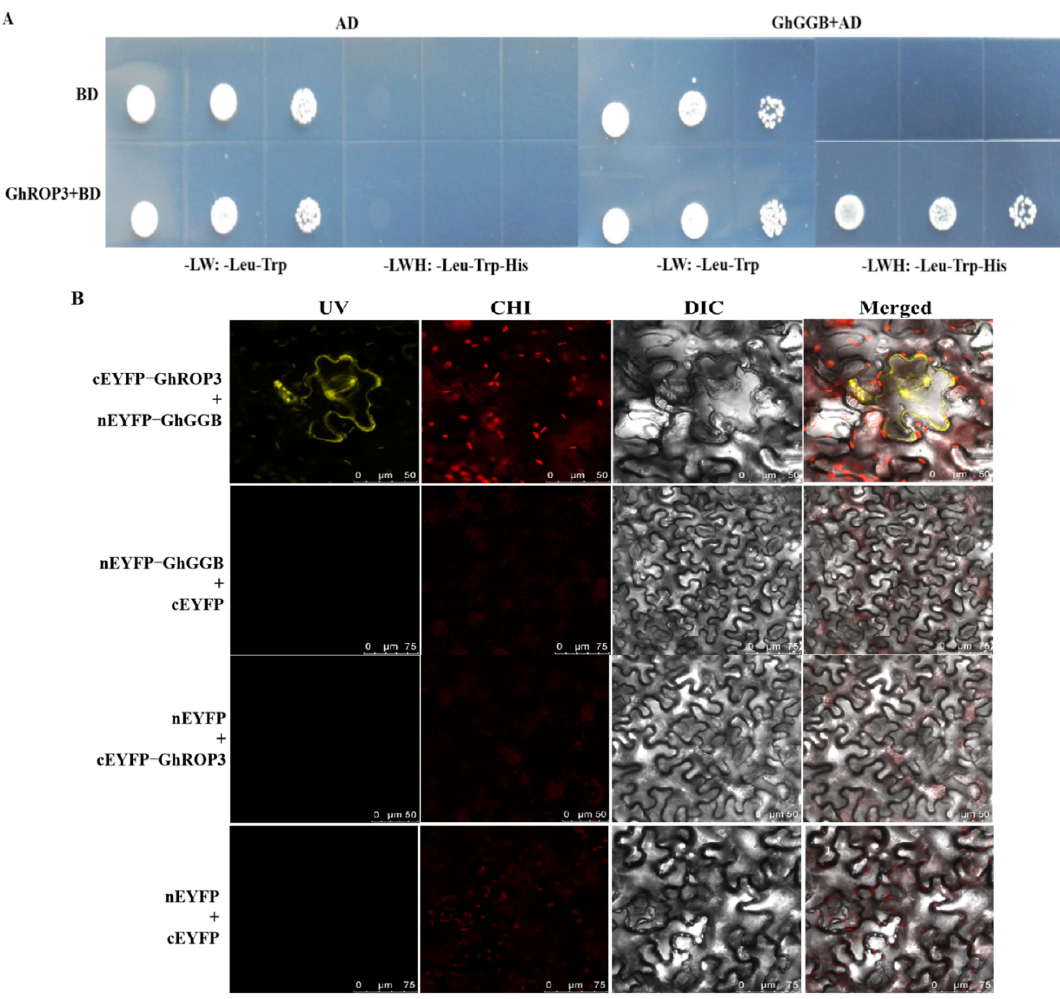
Figure 2. GhROP3 protein interacted with the GhGGB protein. ( A ) Yeast two-hybrid assay.